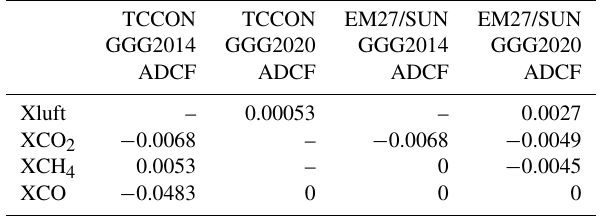
Table 3. Air-mass-dependent correction factors (ADCFs) used for TCCON and EM27/SUN devices. A dash (–) indicates that the value is not calculated or